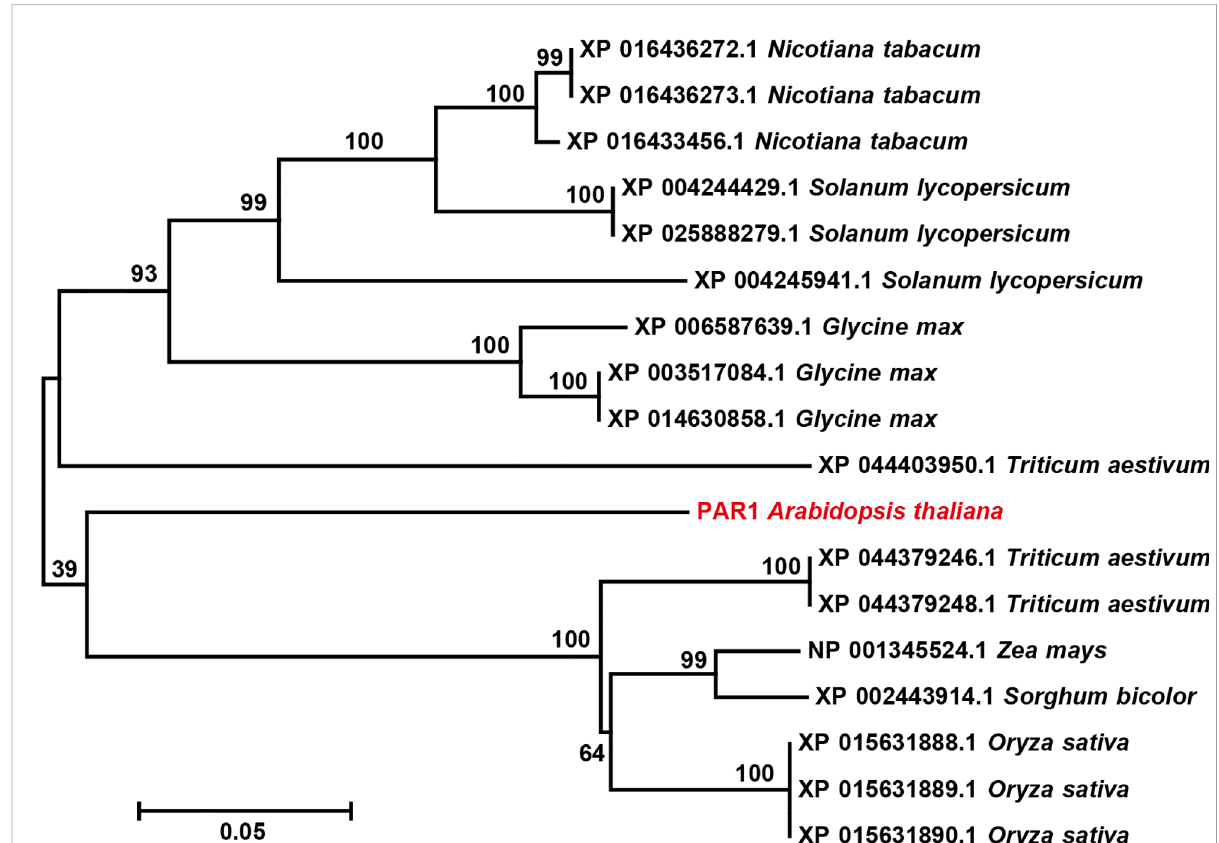
FIGURE 6 The phylogenetic analysis of PAR1 and PAR1 homologs in several crops. Arabidopsis PAR1is highlighted in red. The numbers above the branches indicate bootstrap values. The bar indicates a genetic distance of